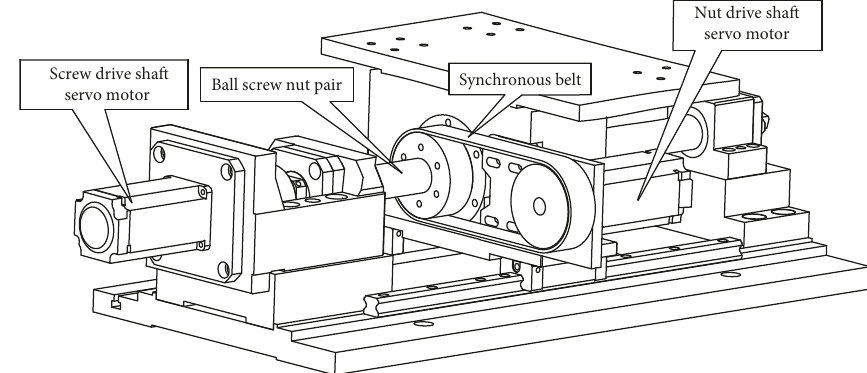
Figure 1: Schematic diagram of mechanical structure of the two-axis differential microfeed system.